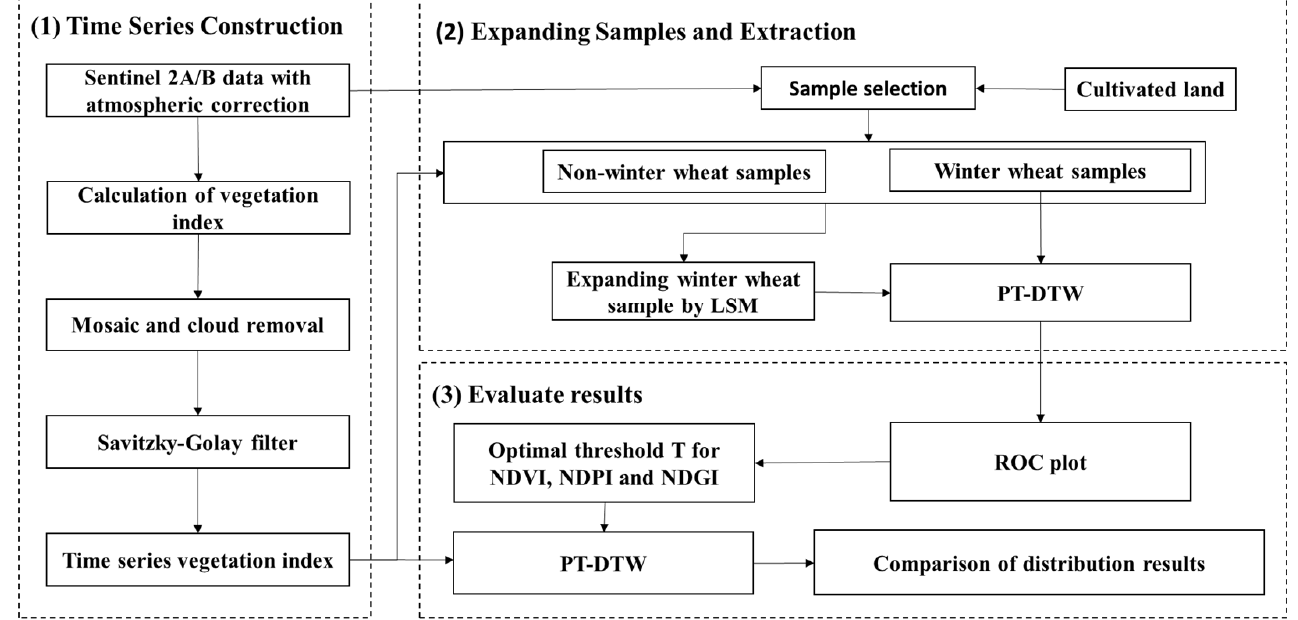
Figure 2. Conceptual diagram of the process used for winter wheat identification.